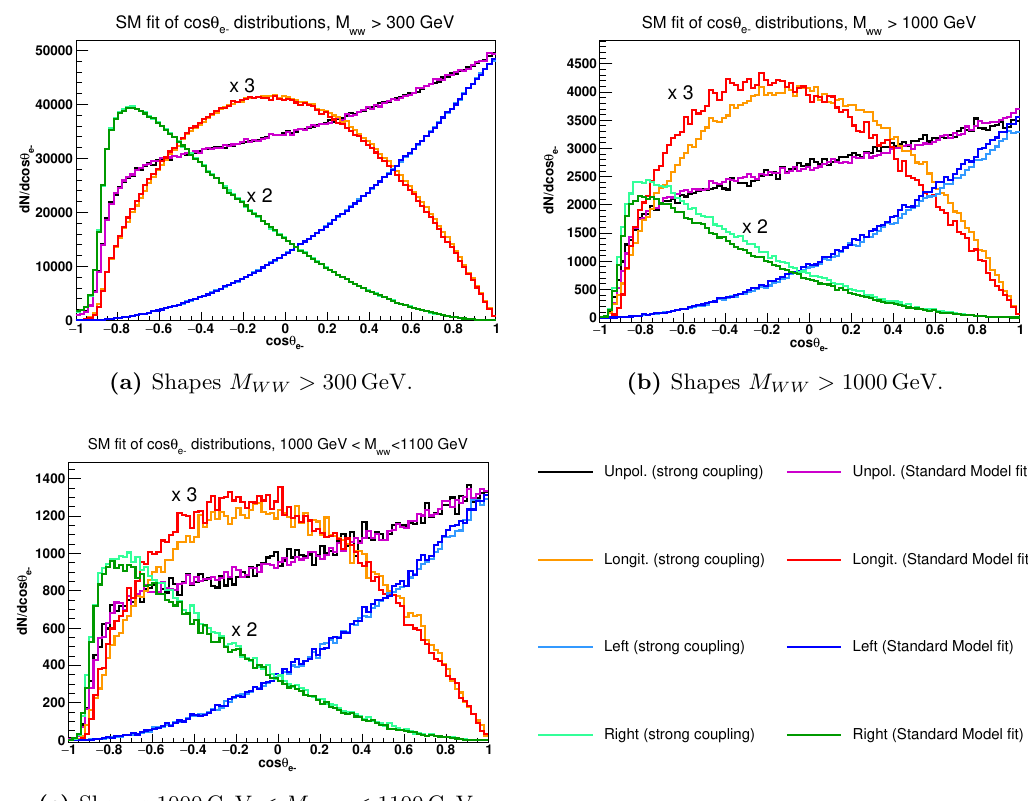
Figure 9. Shape comparison between SM and Higgsless generation. p e longitudinal and right handed components have been multiplied by three and two,